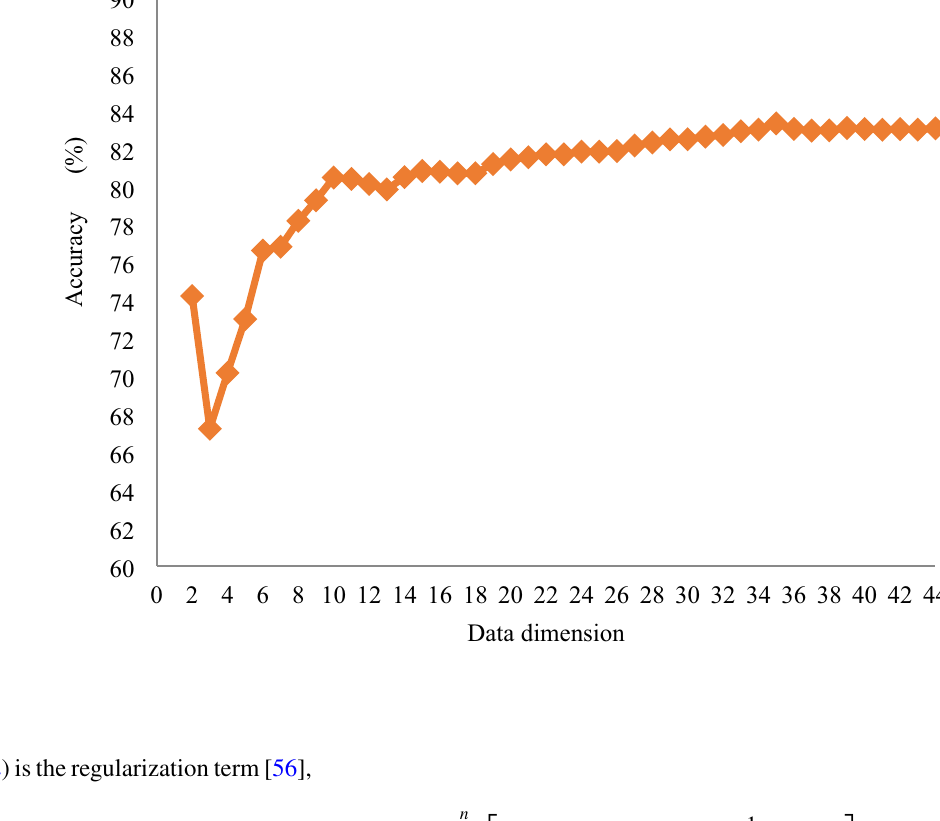
Fig. 4 Classification accuracy rate vs. data